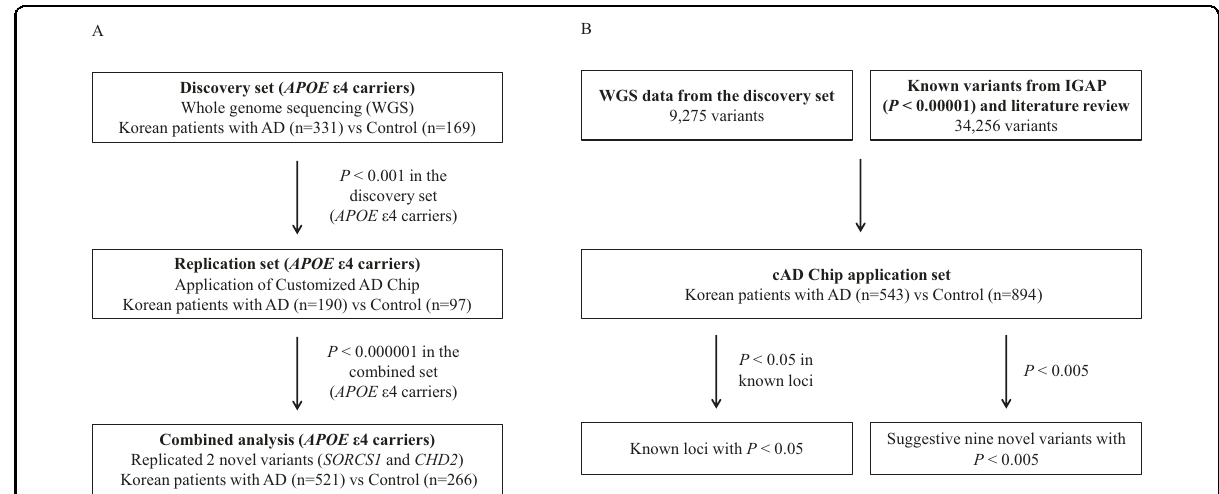
Fig. 1 Schematic work fl ows. The schematic work fl ow shows the procedures for detecting novel genetic variants associated with Alzheimer ’ s Disease (AD) in a Korean population of APOE ε 4 carriers ( A ) and for assessing the reproducibility of previously reported AD loci and suggestive novel loci shown to be population-speci fi c ( B ). cAD customized genotyping AD chip, IGAP International Genomics of Alzheimer ’ s